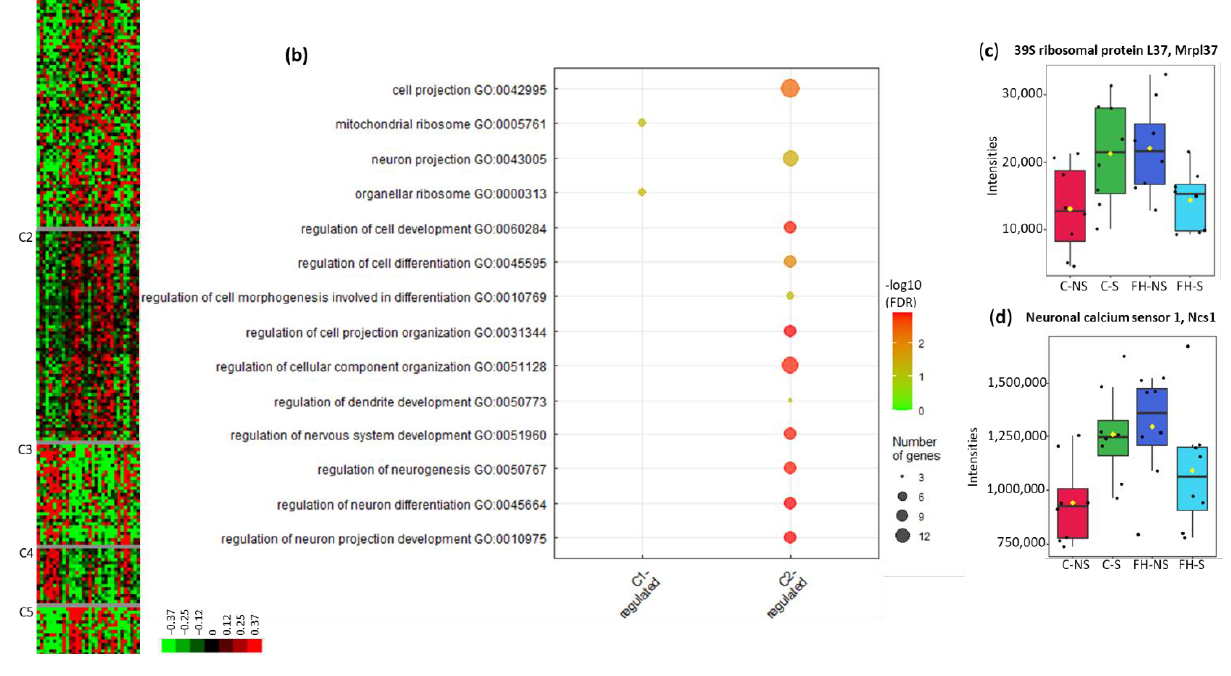
Figure 6. Proteins differentially expressed with the interaction stress x supplementation ( n = 205). ( a ) Unsupervised Bayesian clustering for the four groups ( n = 8/group). ( b ) Gene ontology (GO) term enrichment from clusters C1 and C2. ( c ) Box plots of 39S ribosomal protein L37 from cluster C1. ( d ) Box plots of neuronal calcium sensor 1 from cluster C2. Table 4. Proteins from mitochondrial pathways modulated by the interaction stress x supplementation.